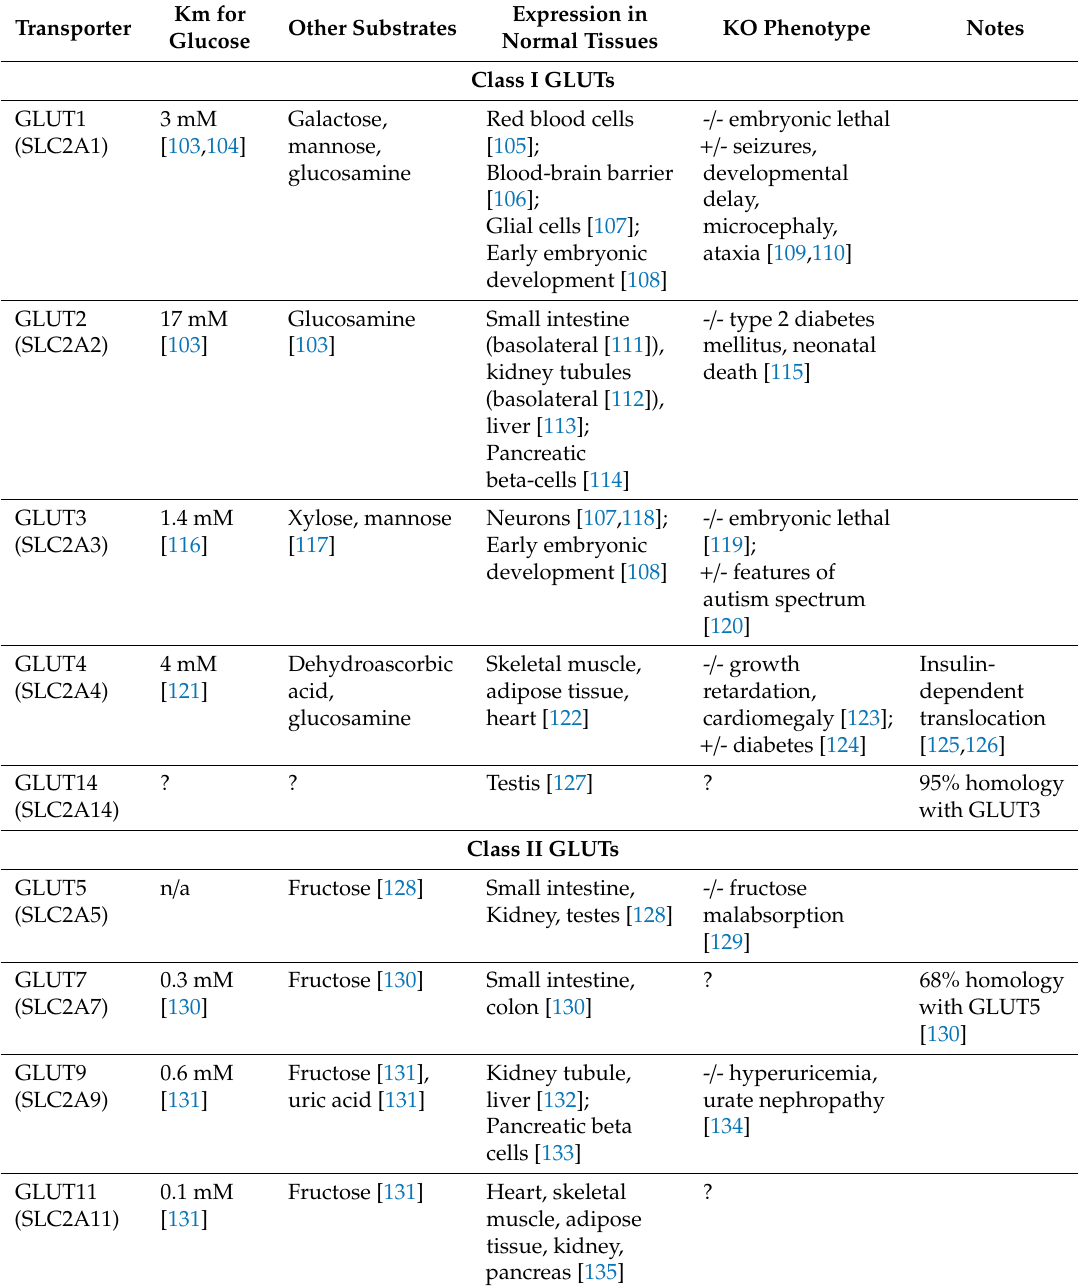
Table 1. Physiological properties of glucose